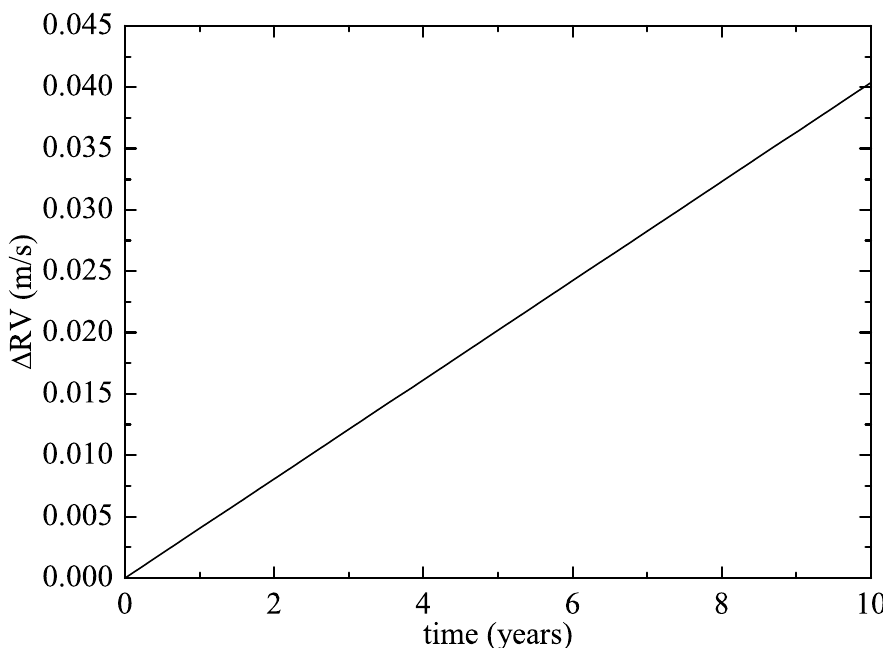
Figure 3. Perturbation in the radial velocity of Proxima Centauri as a consequence of the extra forces of MNG model as a function of